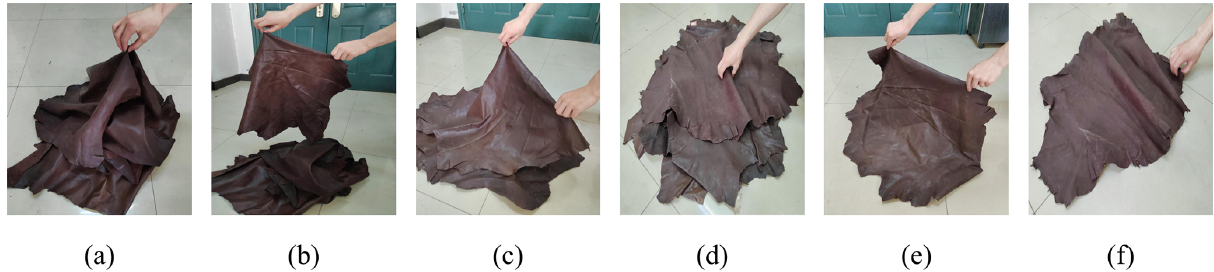
Figure 1. Example of the grab-and-spread action. (a) Grab and lift the leather through the leather bulge or edge part for the leather in the wound and stacked state. (b) Stretch the edge of the leather with both hands, and make the leather flat in a large area under the action of gravity. (c) Lay the leather flat and stacked. (d) Grab the top layer of leather in a multi-layer tiled stacked state. (e) Lay the single-layer leather flat. (f) Grab the leather edge for stretching and spreading.